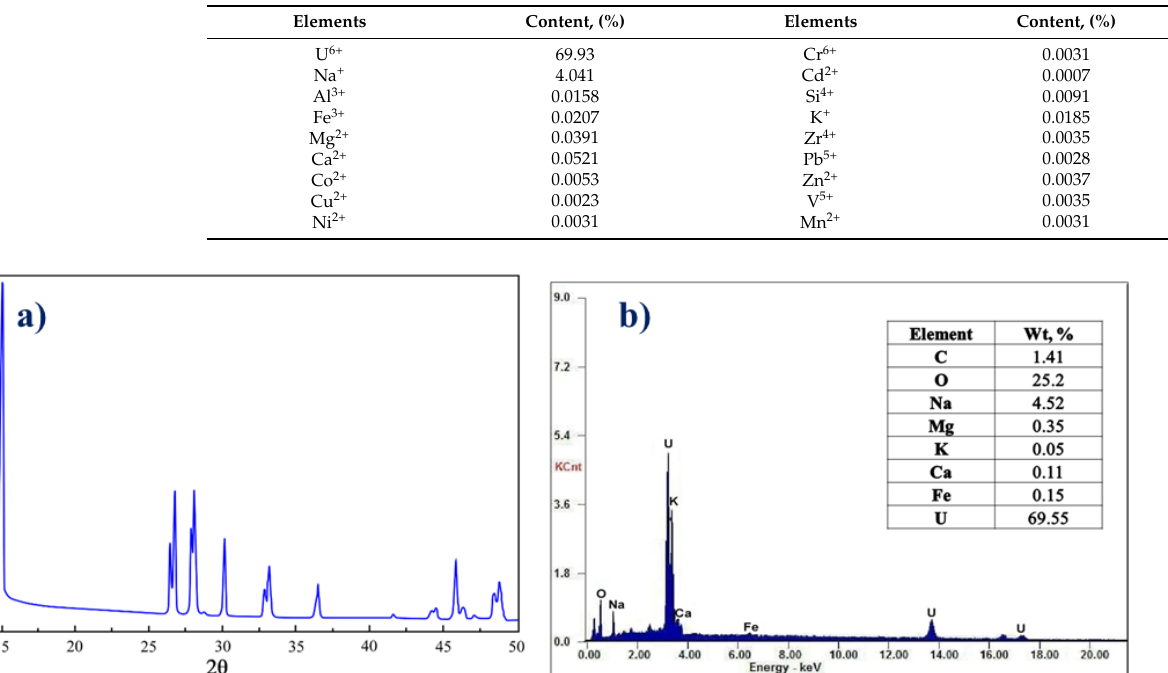
Figure 12. ( a ) XRD spectrum; ( b ) EDX spectrum of Na 2 U 2 O 7 product from G. Gattar granite ore sample.